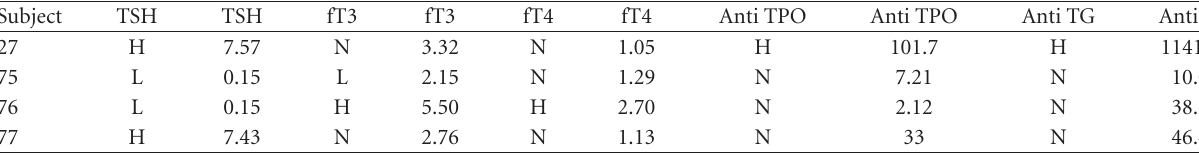
Table 3: Thyroid functions and anti-thyroid antibody levels in control subjects with thyroid